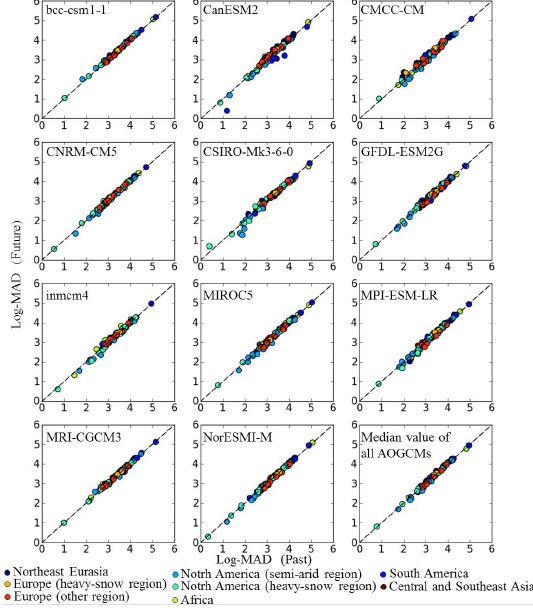
Fig. A3. Comparisons of the maximum proportion of the year dur- ing which no 1.67yr floods have ever occurred (TH3) between past and future in each of the 11 coupled atmosphere–ocean general cir- culation models.